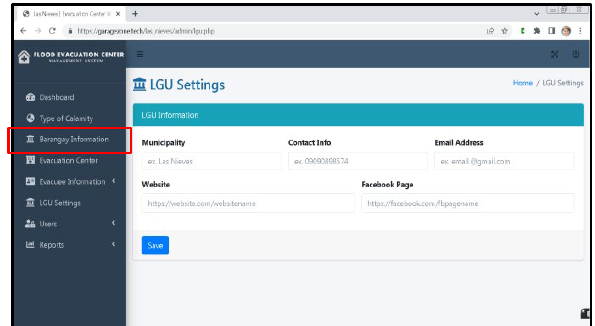
Figure 21. Function LGU Settings customized for the municipality of Las Nieves